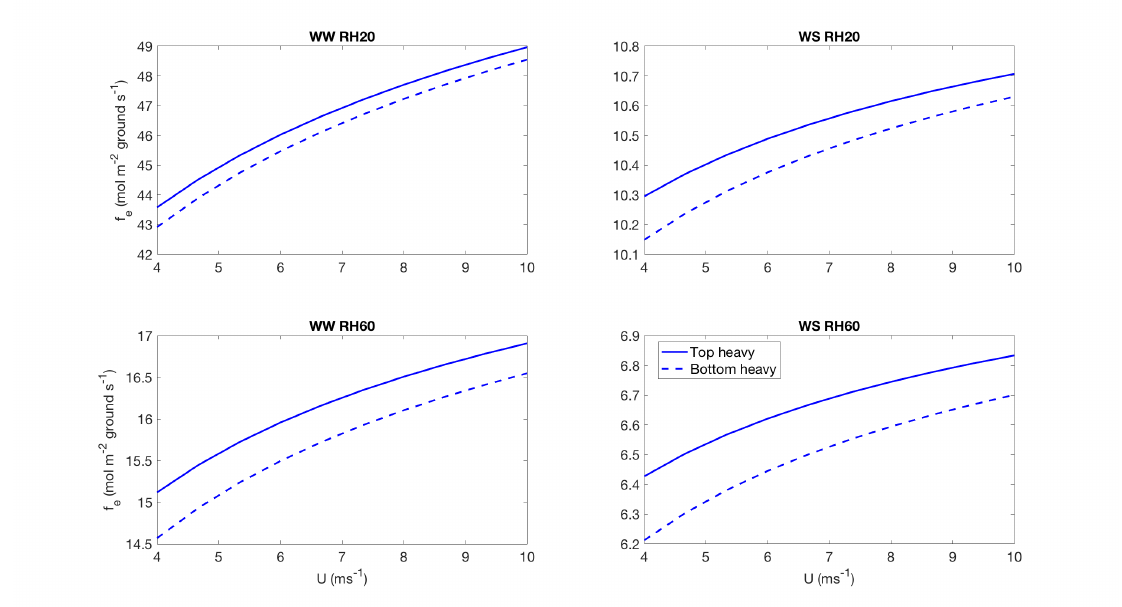
Figure 9. Variation of canopy level transpiration with wind speed for the four scenarios for both top heavy (solid line) and bottom heavy (dashed line) scenarios in high light